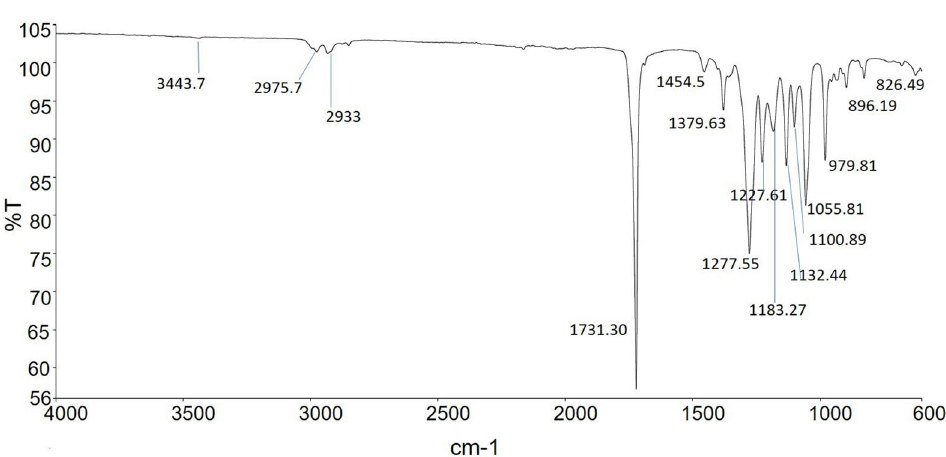
Figure 4. Fourier transform infrared spectroscopy (FTIR) spectrum of PHB produced by Rhodococcus pyridinivorans